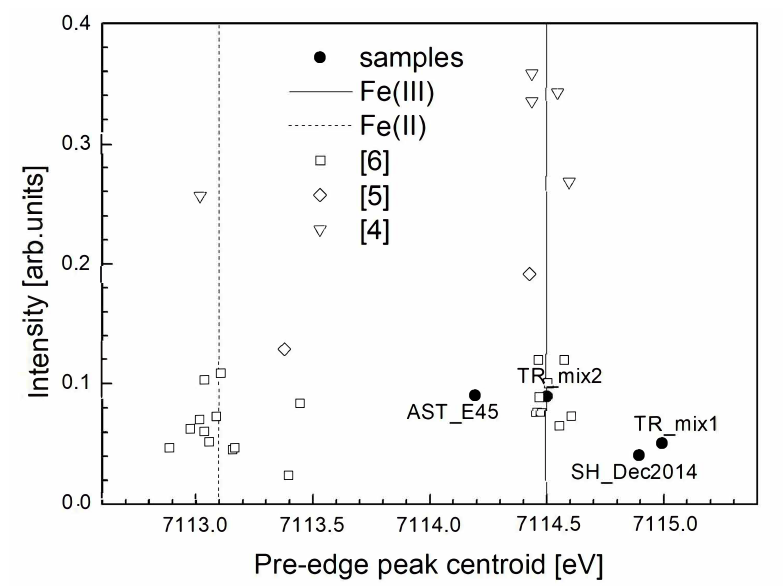
Figure 3. Pre-edge peak intensity vs. centroid position. Comparison between samples (SH_Dec2014, AST_E45, TR_mix1 and TR_mix2; solid dots) and the standard compounds reported in Wilke et al. [46] (open